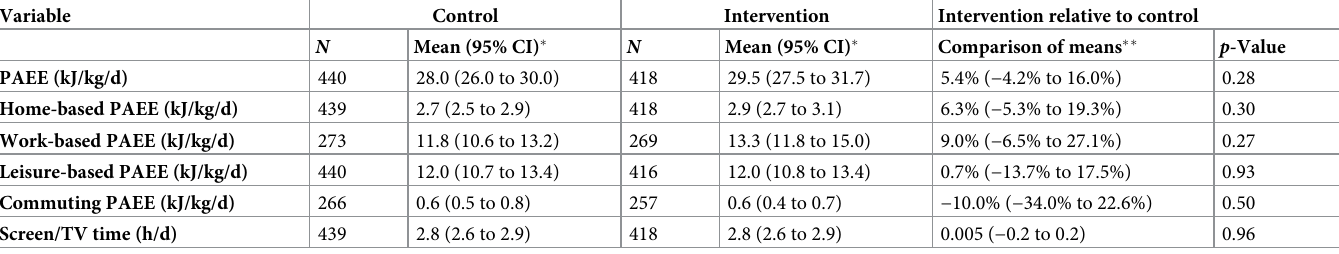
Table 4. Self-reported physical activity by study group and between-group differences at 3-month